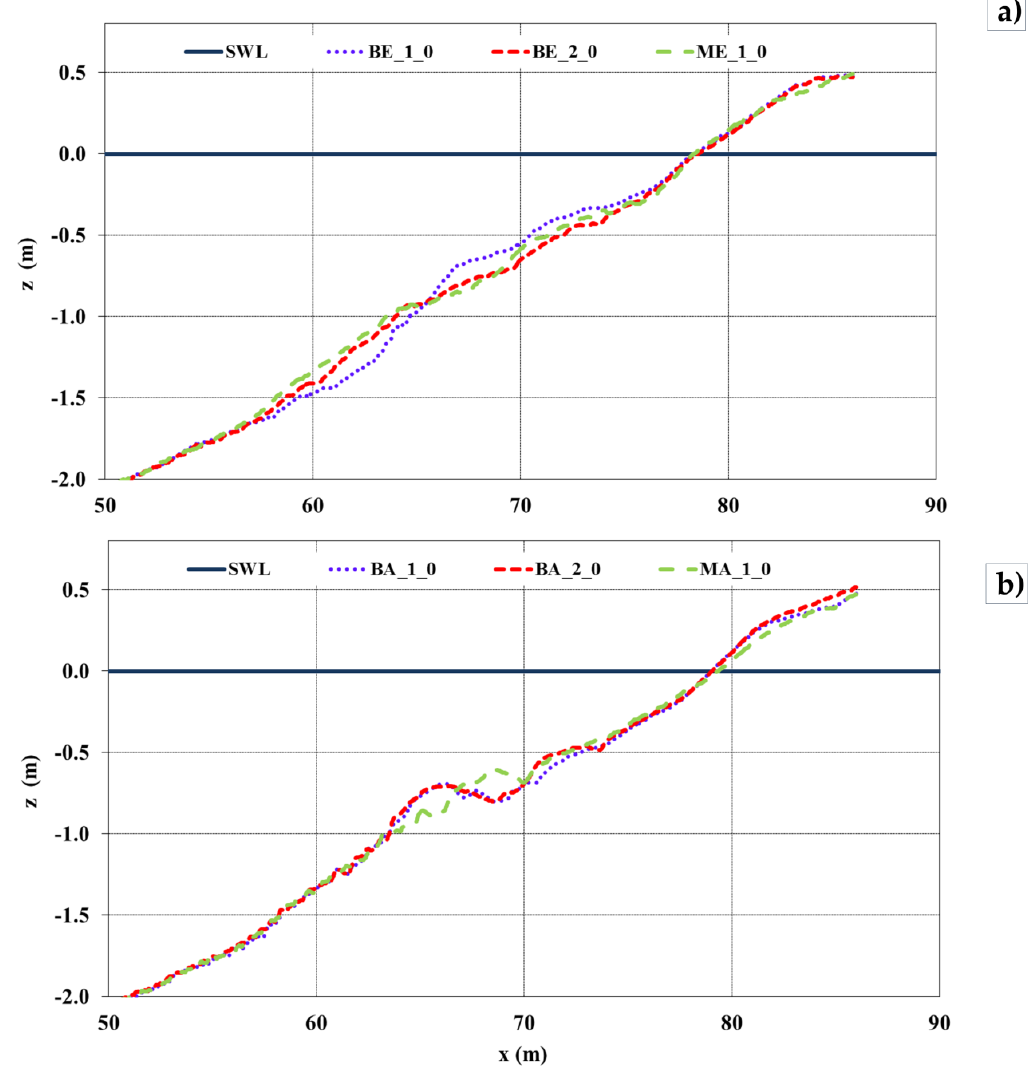
Figure 2. Initial beach profiles: ( a ) for erosive tests; ( b ) for accretive tests. Still water level SWL (dark blue line), BE_1_0 and BA_1_0 profiles (dashed blue lines), BE_2_0 and BA_2_0 profiles (dashed red lines) and ME_1_0 and MA_1_0 profiles (dashed green lines) are shown.